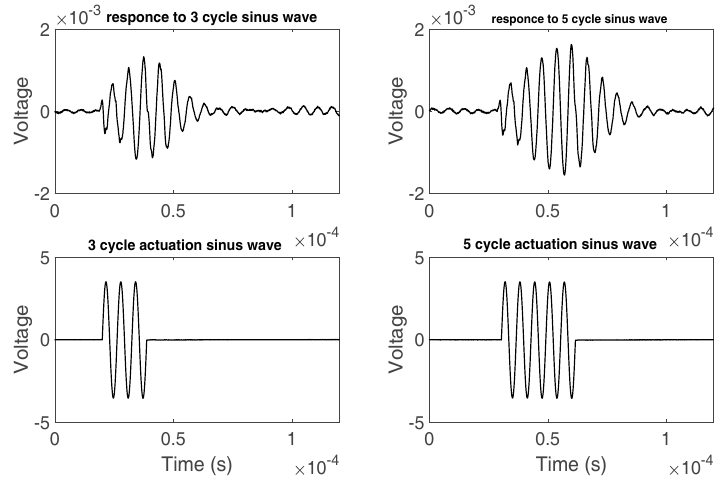
Figure 3. The pulse response of the transducer to a 3 and 5 cycles sinus